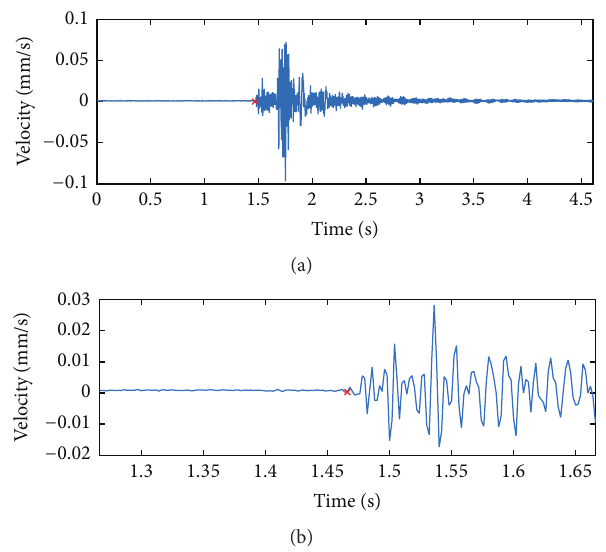
Figure 1: Exemplary seismic event with P-wave arrival determined by specialists (a) and its zoom